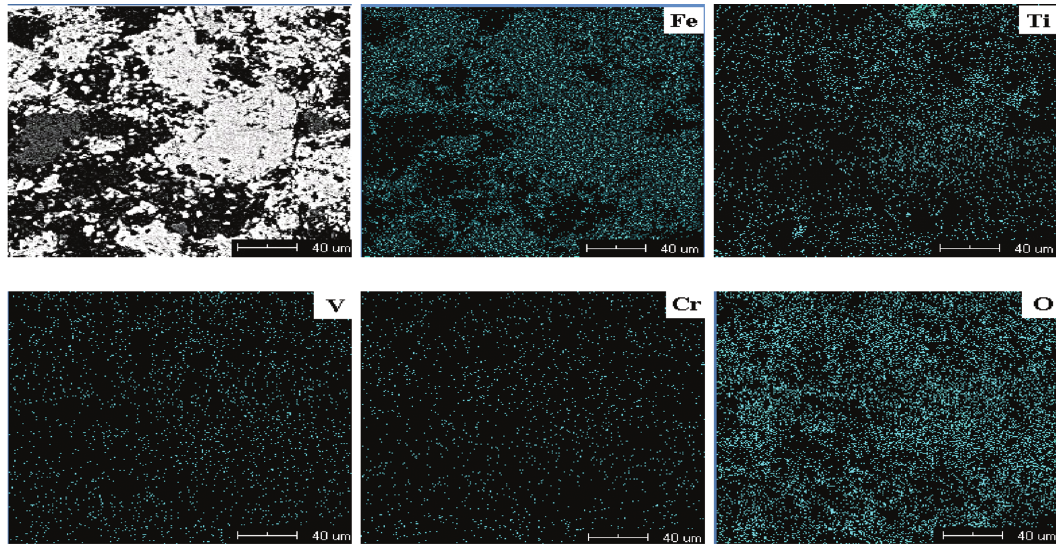
Figure 14: Distribution of Fe, Ti, V, Cr and O in HCVTM pellet roasted at 1,573 K for 20